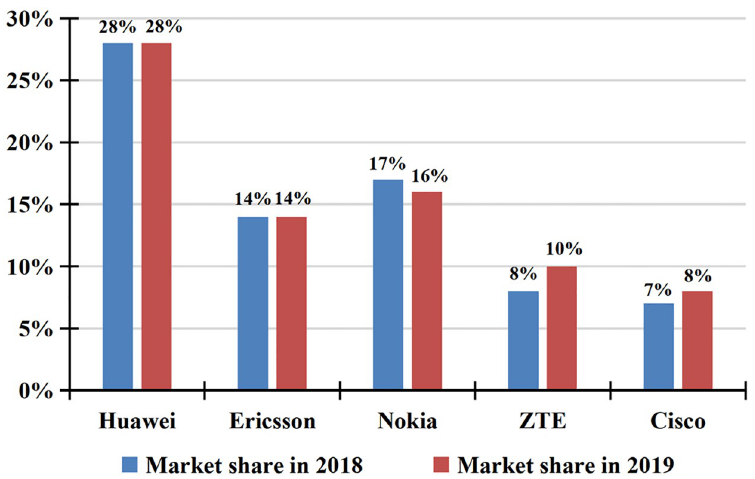
Fig 2. Global telecom equipment market revenue 2018–2019. (Data source: China’s New Generation AI Technology Industry Development Report (2019), Evergrande Research Institute).